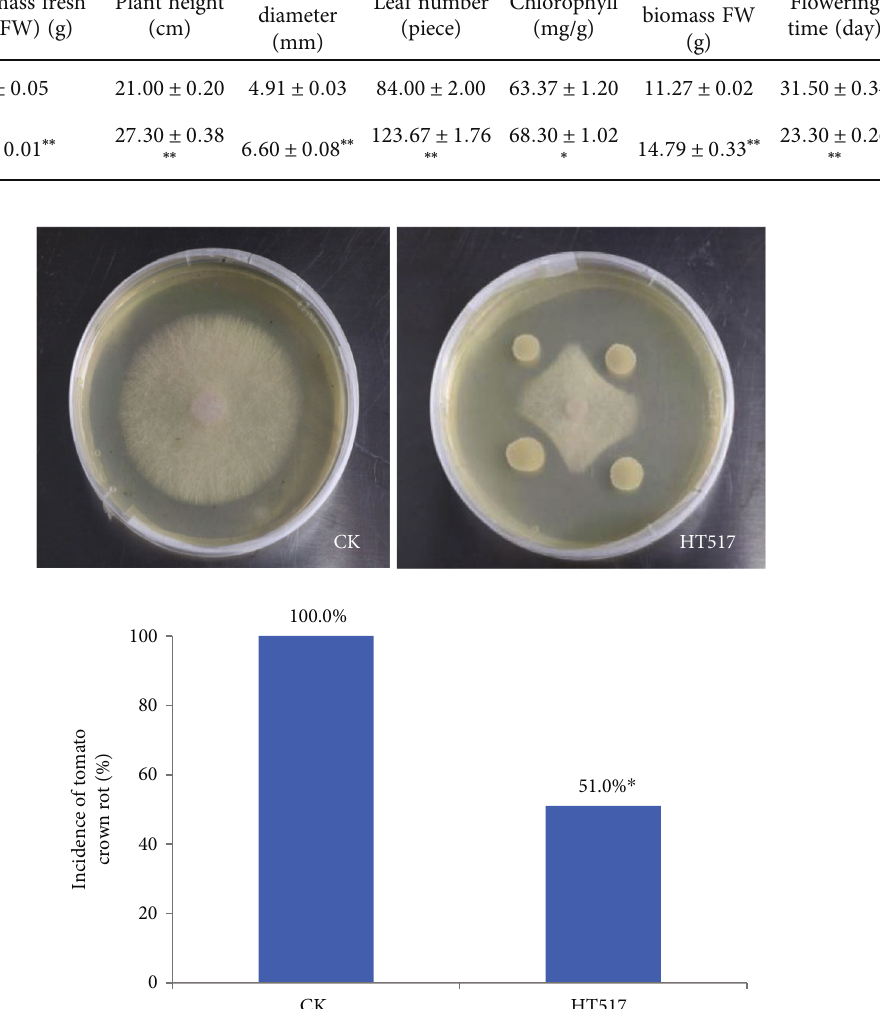
Figure 1: E ff ects of Bacillus megaterium on fungal tomato pathogen Fusarium oxysporum f. sp. lycopersici